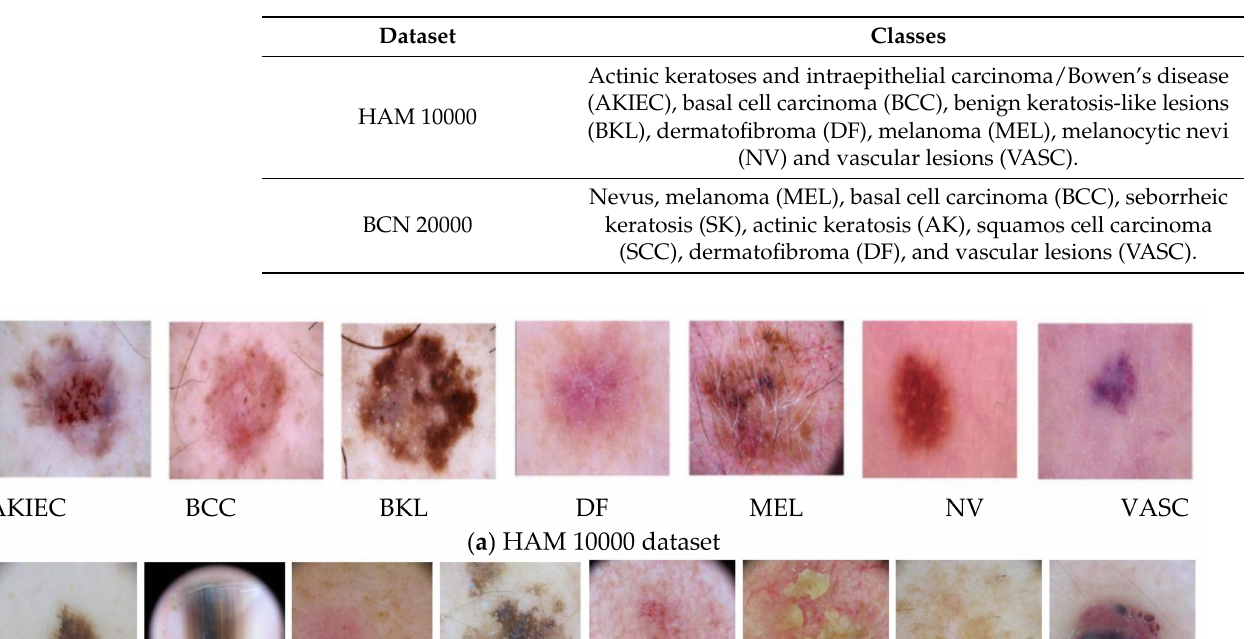
Table 1. Datasets and description of skin lesion classes.